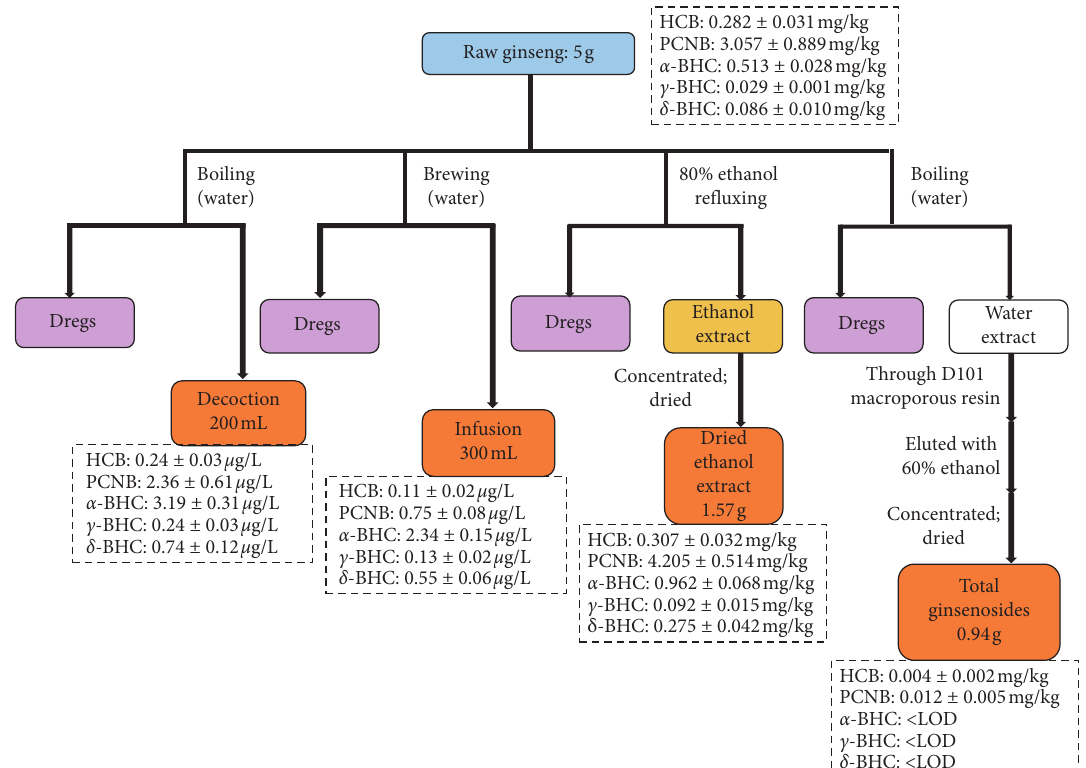
Figure 2: Ginseng processing flow diagram, sample steps, and pesticide concentration in each critical stage. Values correspond to the average of three